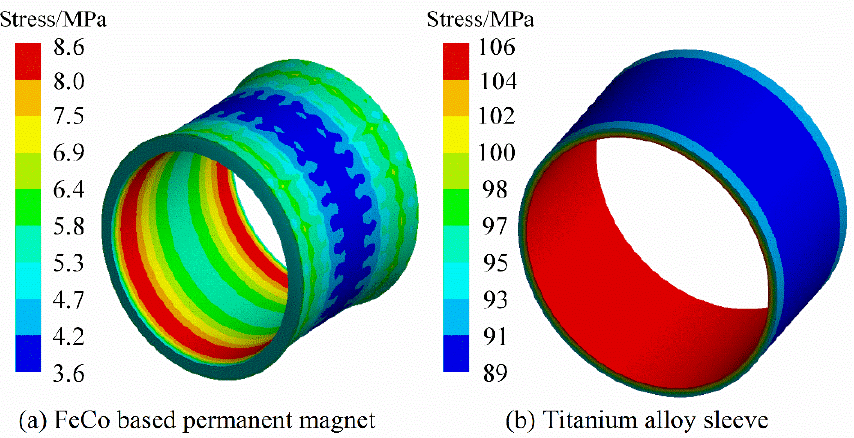
Figure 3. Von-Mises stress distribution of FeCo-based PM and sleeve under steady condition.